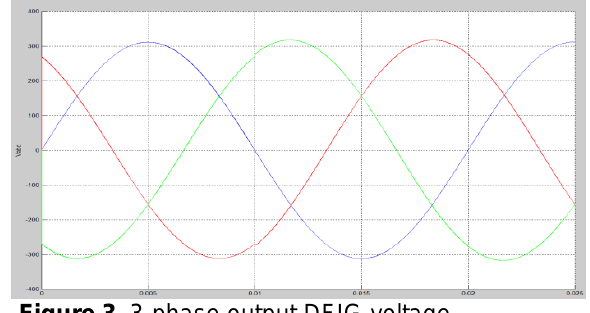
Figure 3. 3-phase output DFIG voltage.